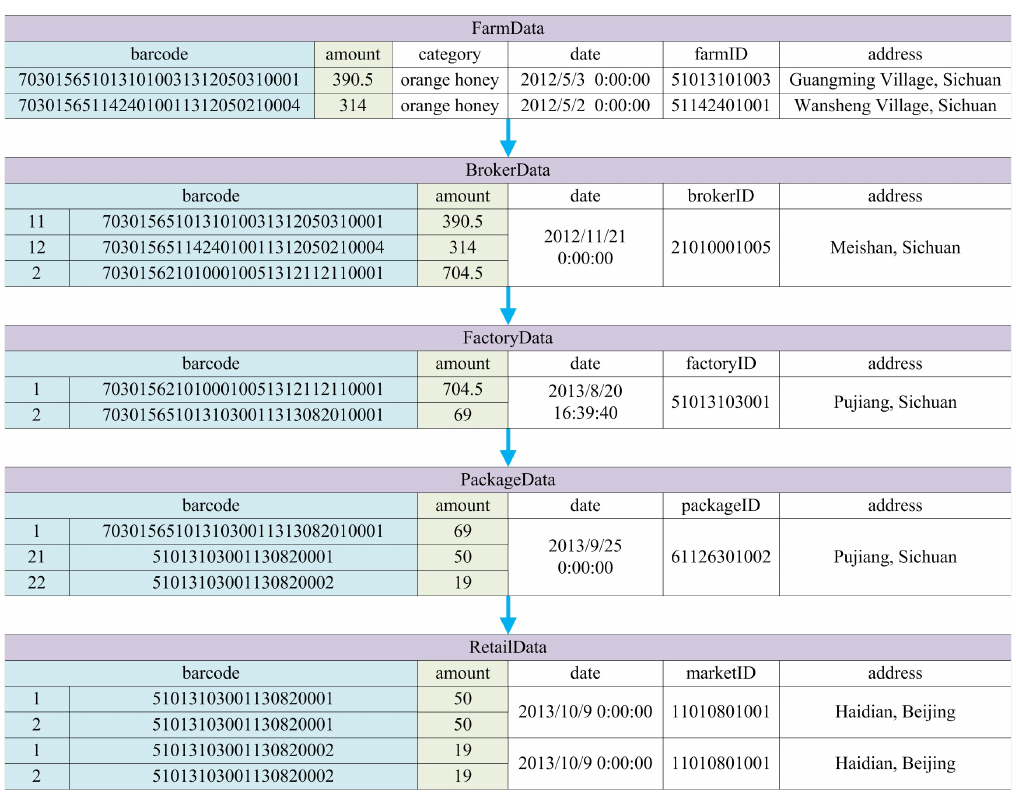
Figure 12. PPN model of the manufacturing process of an orange honey product.